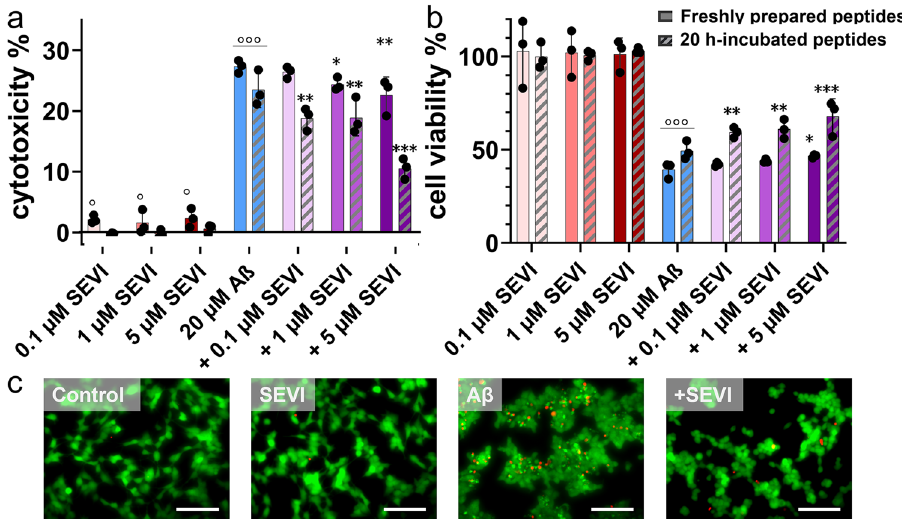
Fig. 3 Cross-seeding of SEVI with A β protects cells from A β -induced toxicity. a cell cytotoxicity from LDH assay and ( b ) cell viability from MTT assay when the incubation of A β (20 μ M) with and without SEVI at molar ratios of 1:005, 1:05 and 1:0.25 for 24 h. Untreated cells were set as control (100% MTT reduction and 0% LDH activity), cells treated with Triton-X-100 were set for 100% LDH activity. All data represent mean ± s.d. of three independent experiments. Statistical analysis ( n = 3) was conducted for cells with both SEVI and A β relative to untreated cells (° p < 0.05; °° p < 0.01; °°° p < 0.001) or cells treated with A β alone (* p < 0.05; **p < 0.01; *** p < 0.001). c Representative fl uorescence microscopy images of cells treated for 24 h with 20 h- incubated A β (20 µ M) in the absence or presence of 5 µ M SEVI. Untreated cells were set as control. Red and green fl uorescence indicate the dead and live cells, respectively. Scale bars are 100 µ